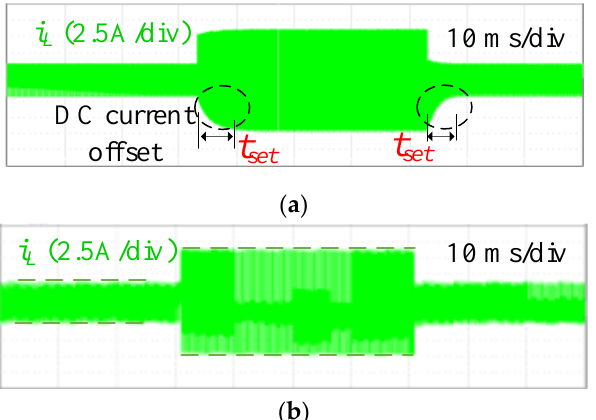
Figure 8. Zoomed-out waveforms during the step change of the current reference for forward power transmission. ( a ) CSPS modulation-based current controller. ( b ) ESPS-PCM controller.